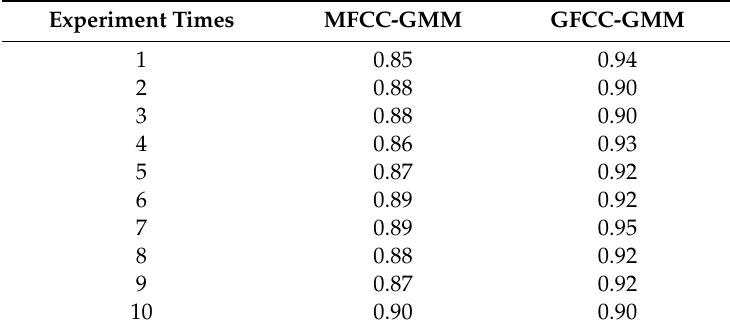
Table 1. The estimated optimal threshold and η of 20 di ff erent underwater sonar images. Experiment Times